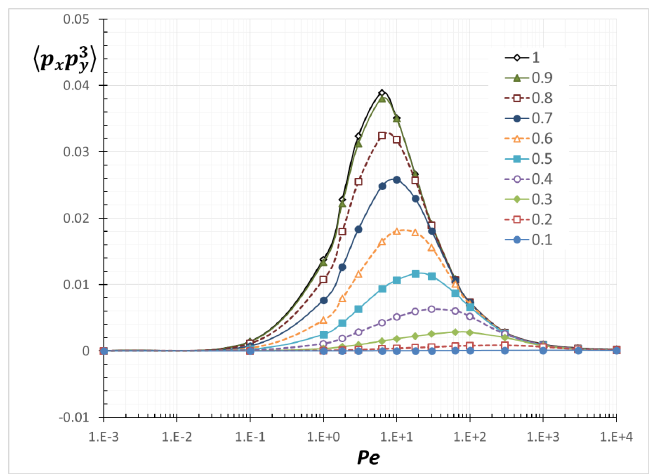
Figure 15. Average orientation moment < p x p y3 > as a function of Pe with various α / a .